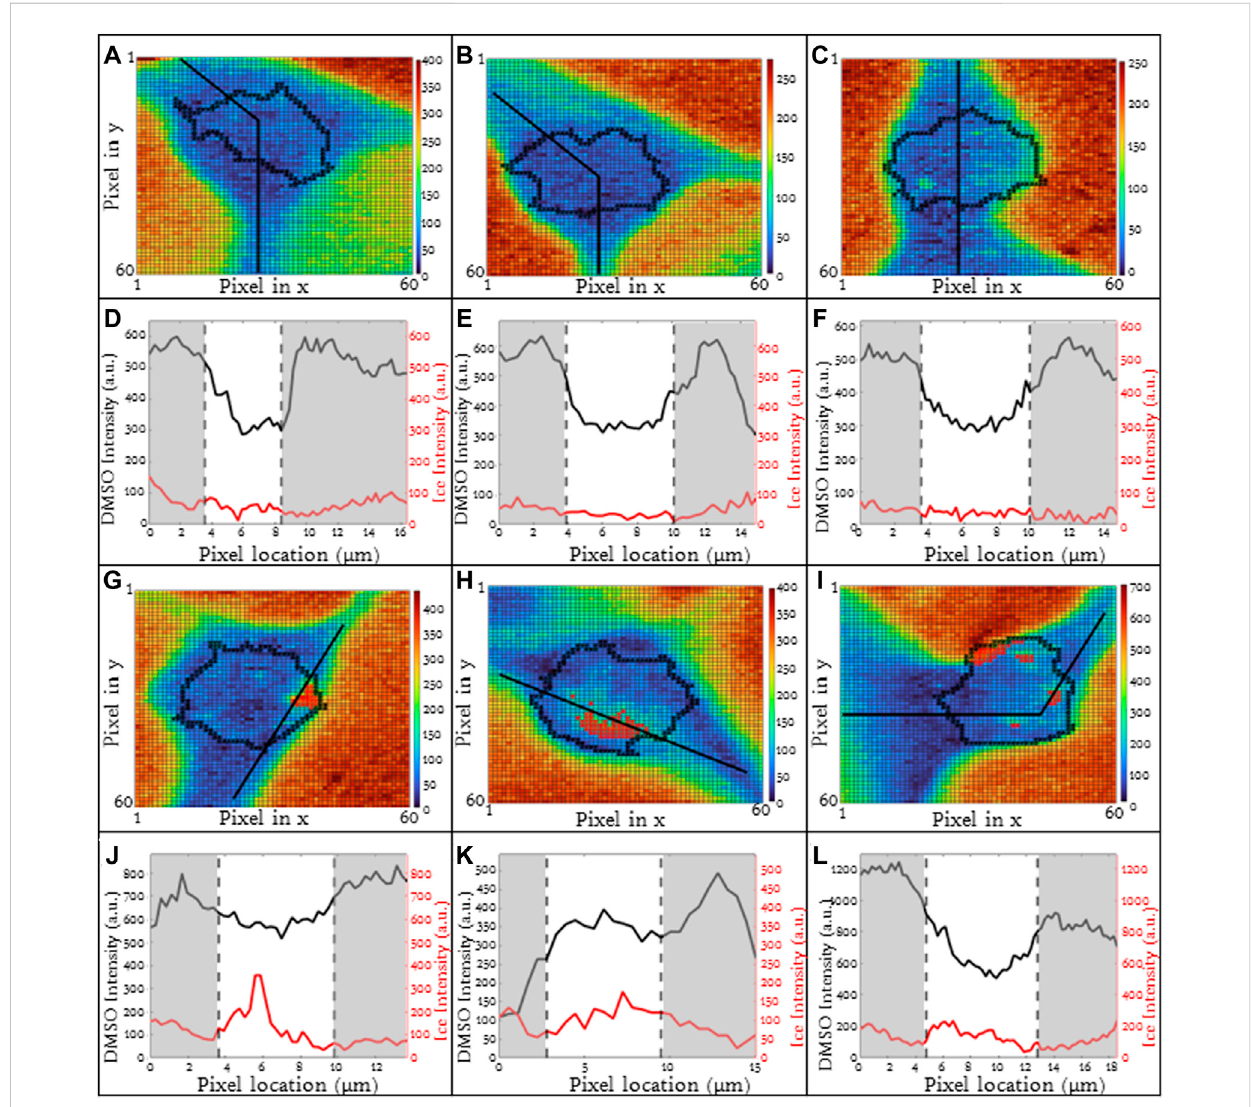
FIGURE 5 (A – C) Raman heat maps of three different Jurkat cells in 5% DMSO frozen using a − 10 ° C/min cooling rate with no intracellular ice formation using the ice (OH) signal. The respective (D – F) line scans of DMSO and ice intensities across extracellular and cellular regions. (G – I) Raman heat maps of three differentJurkatcellsin5%DMSOfrozenusinga − 10 ° C/mincoolingratewithextensiveintracellulariceformationusingtheice(OH)signal.Therespective (J – L) line scans of DMSO and ice intensities across extracellular and cellular regions. Pixels in (A – C) and (G – I) have a height and width of 250 nm. Red indicates intracellular ice formation and black represents the cellular boundaries. Gray areas indicate extracellular regions and white areas indicate intracellular regions in (D – F) and (J – L)